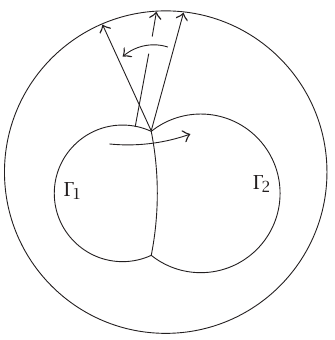
Figure 7.9 . The function f backtracks at the points of intersection of the exterior